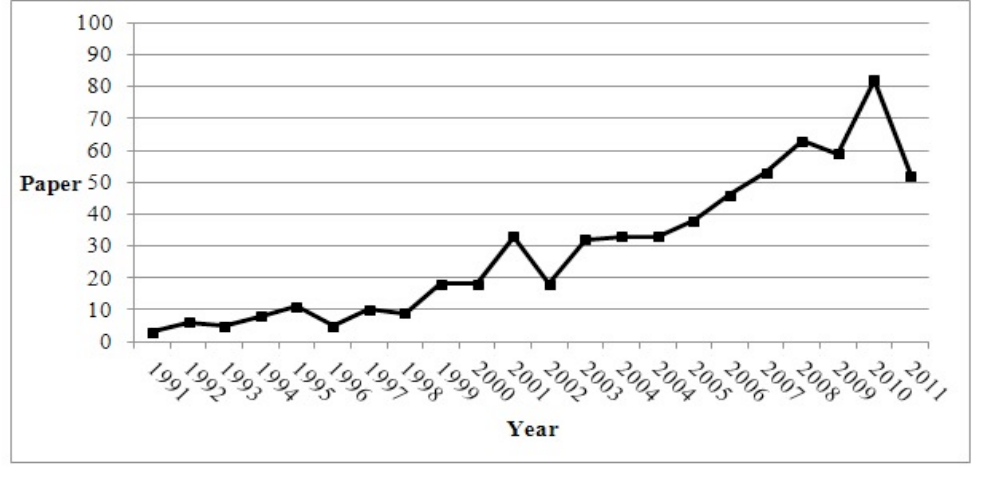
Figure 2. Co-keyword analysis